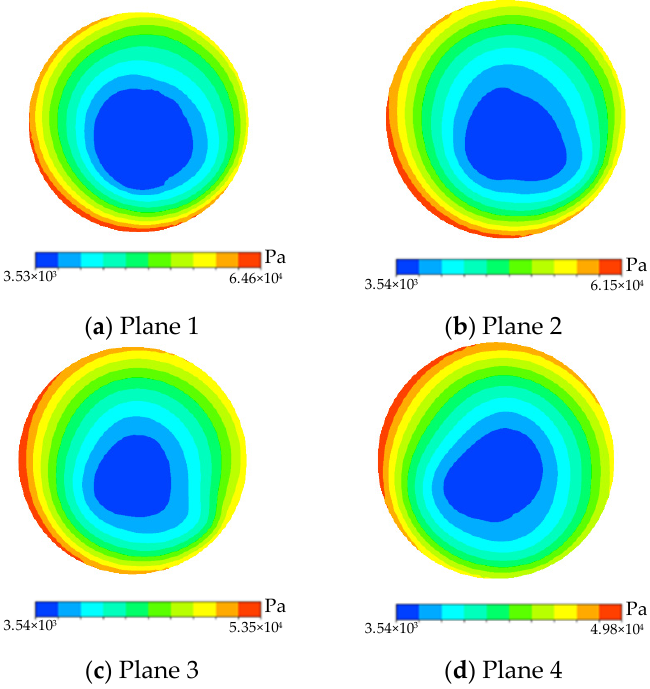
Figure 12. Pressure distribution of the draft tube at t = 6.9 s on different sections.